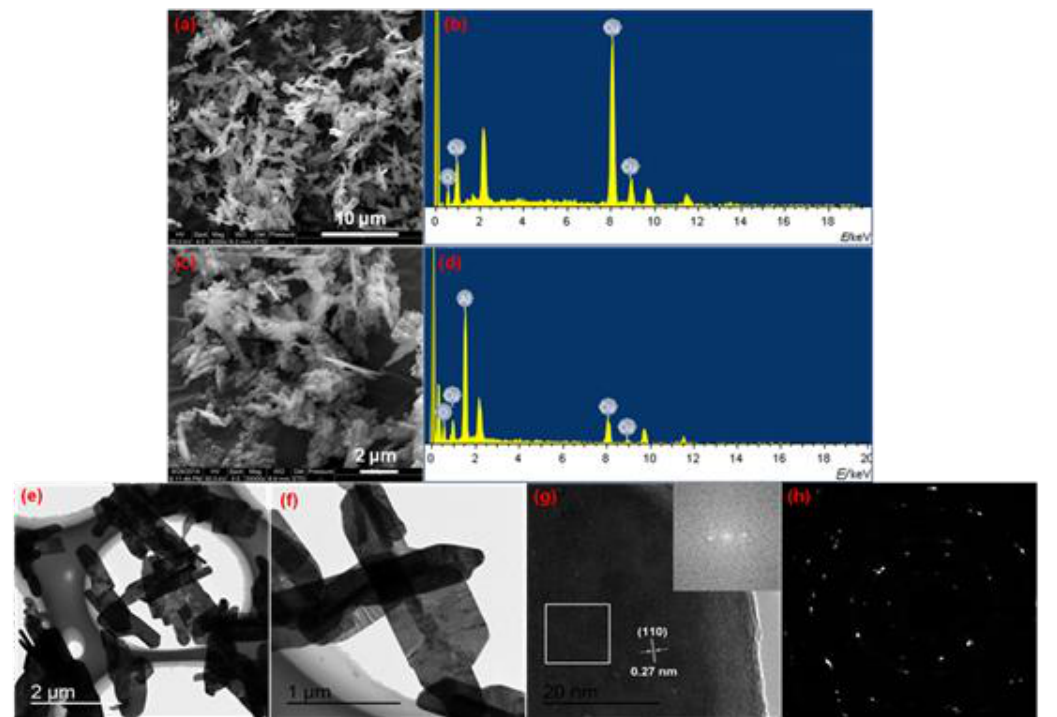
Figure 4. ( a ) SEM image of flaky-shaped CuO(f); ( b ) Energy-dispersive X-ray spectroscopy (EDS) pattern of flaky-shaped CuO(f); ( c ) SEM image of Al/CuO(f) nanothermites; ( d ) EDS pattern of Al/CuO(f) nanothermites; ( e , f ) are TEM images of flaky-shaped CuO(f); ( g ) HRTEM image of flaky-shaped CuO(f) and the corresponding FFT pattern (insert); and, ( h ) SAED pattern of flaky-shaped CuO(f).